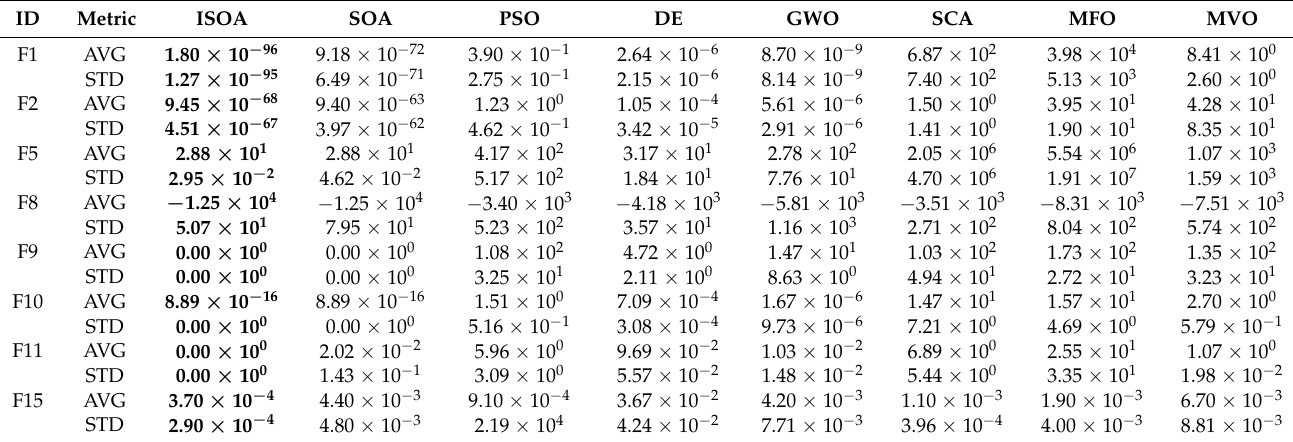
Table 6. Test results of 50 trials of ISOA and other